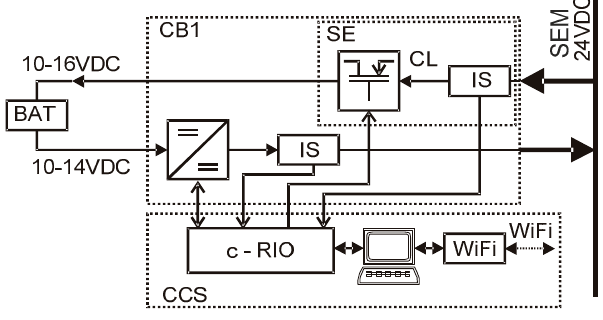
Figure 7. A diagram of the CB1 power controller.